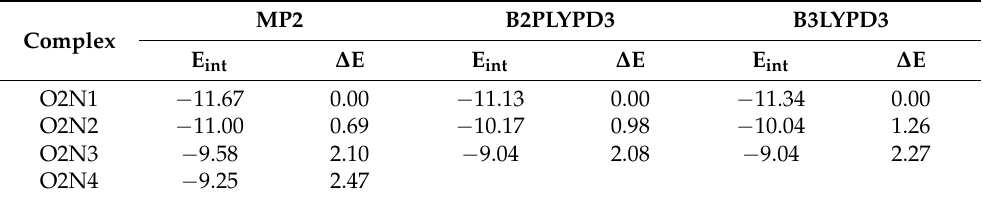
Table 3. BSSE corrected interaction energies E int and relative energies ∆ E (kJ mol − 1 ) of the HNCO · · · N 2 complexes of the 1:2 stoichiometry calculated at MP2, B2PLYPD3 and B3LYPD3 levels with the 6-311++G(3df,3pd) basis